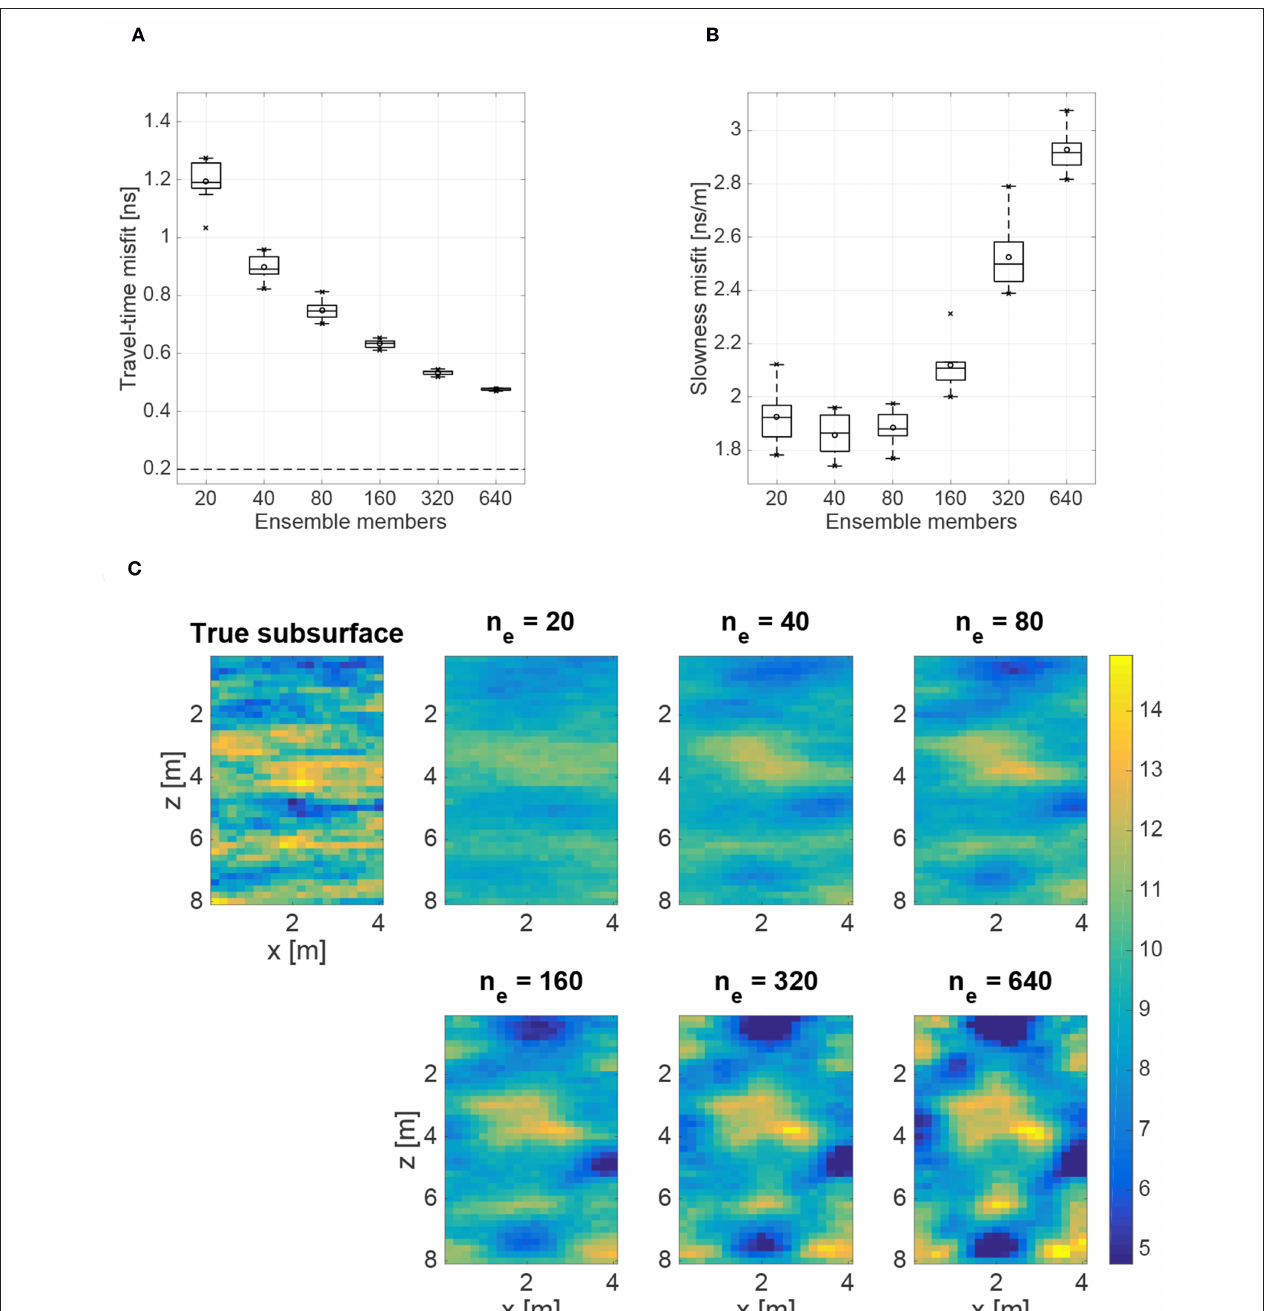
FIGURE 3 | Results of 10 standard ES-MDA runs for the case where model error is present but not accounted for. Shown as a function of the number of ensemble members, n e , are (A) box plots of the average RMS travel-time misfit [ns]; (B) box plots of the average RMS slowness misfit [ns/m]; and (C) the mean posterior slowness fields [ns/m]. Added to the box plots are the mean (circles), and minimum and maximum values (crosses). The dashed horizontal line in (A) represents the expected value of the travel-time misfit assuming that the residuals follow the prescribed Gaussian distribution for the data errors.